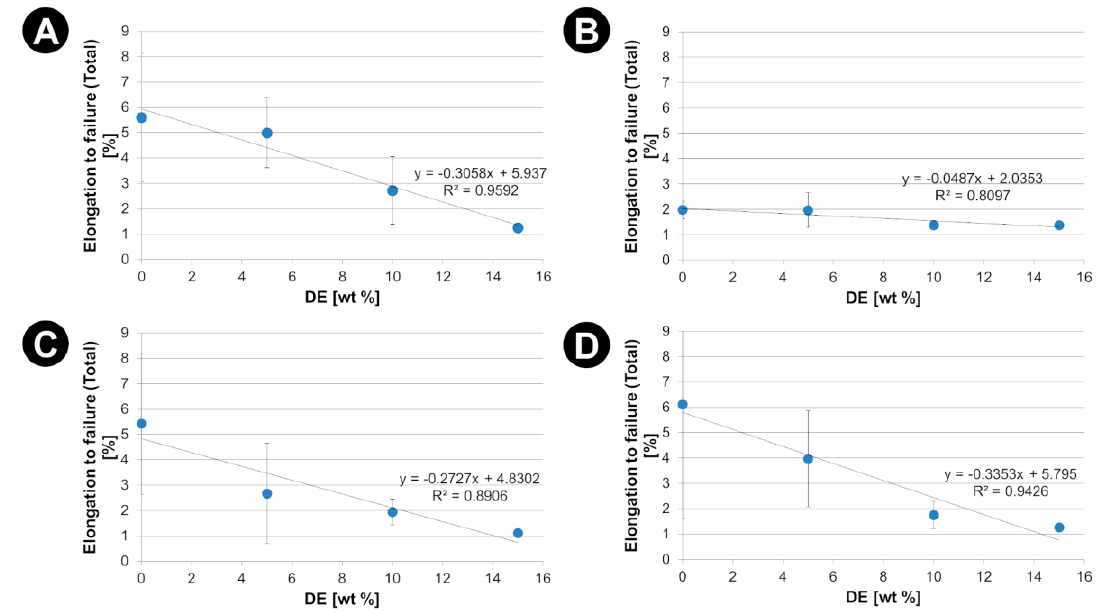
Figure 8. Elongation to failure ( ε f ) against the DE content for PLA-DE composites with ( A ) 2003D; ( B ) 3001D; ( C ) 3251D and ( D ) 4043D PLA as a matrix.